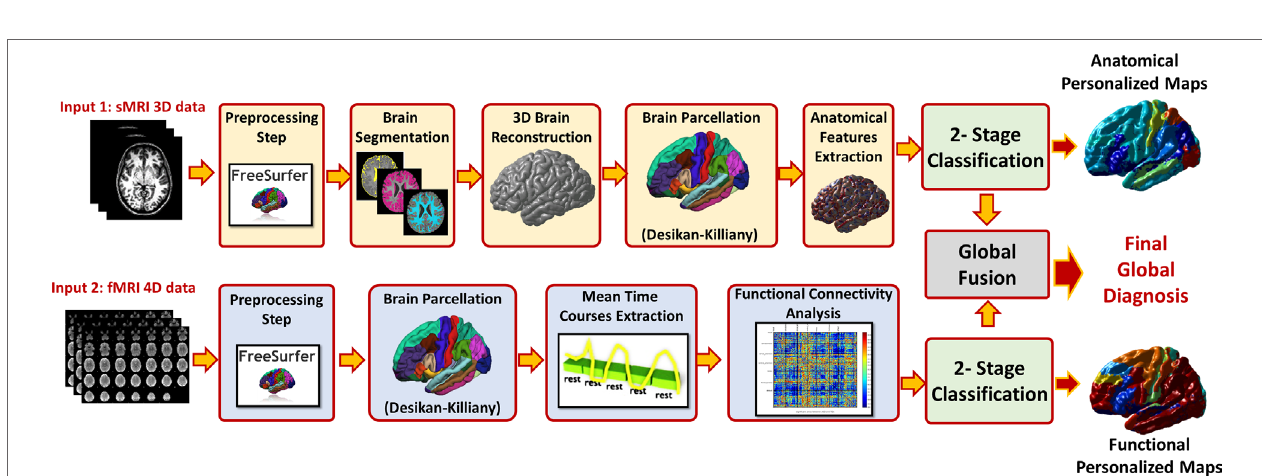
FIGURE 5 | The overall pipeline of the proposed approach, for each modality preprocessing and analysis is applied to calculate the feature matrix. The features of the modality are fed to a local classifier, modality fusion decision is then calculated and finally overall diagnosis decision is reported using both sMRI and fMRI